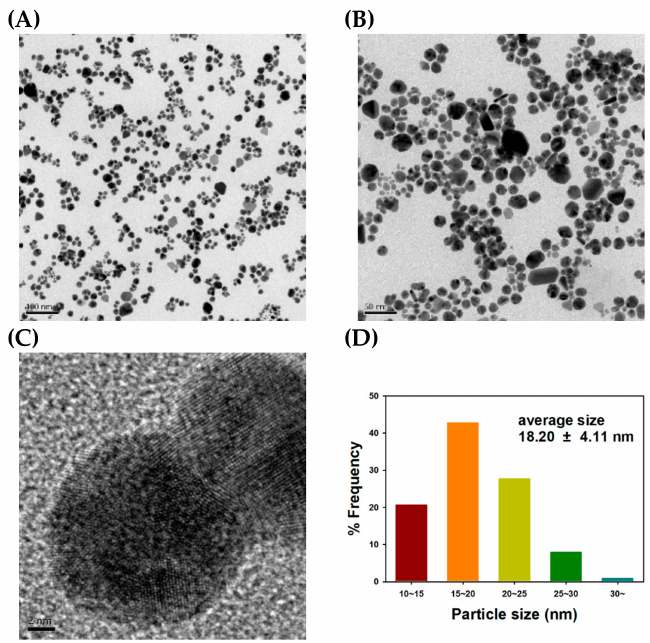
Figure 6. FE-TEM images and a size histogram of TF-AuNPs. The scale bar represents ( A ) 100 nm, ( B ) 50 nm and ( C ) 2 nm. ( D ) A size histogram was determined from the measurement of 213 discreet nanoparticles in FE-TEM images using the Image J program.